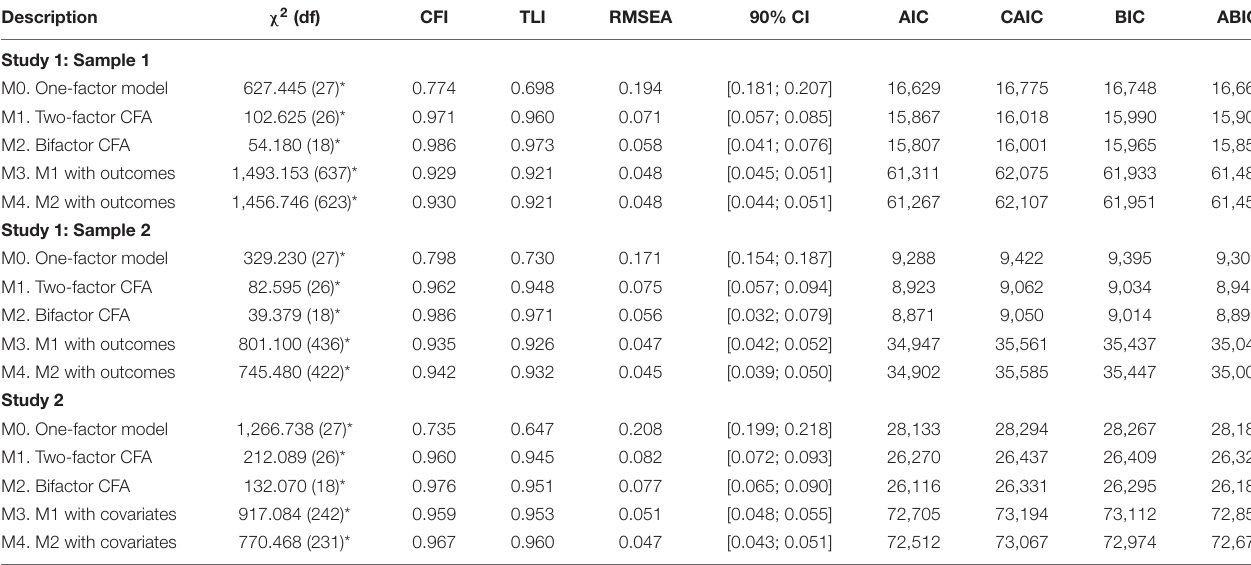
TABLE 1 | Goodness-of-fit statistics for the estimated measurement and predictive models. Description χ 2 (df) CFI TLI RMSEA 90% CI AIC CAIC BIC